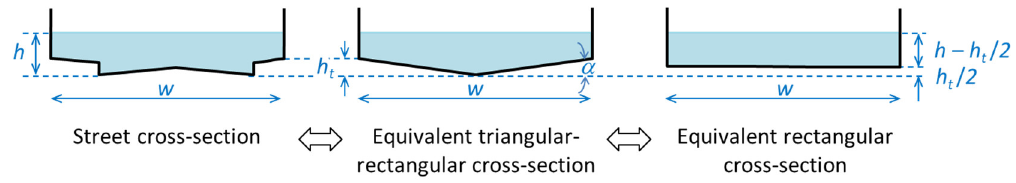
Figure 1. Street cross-section and equivalent cross-sections.